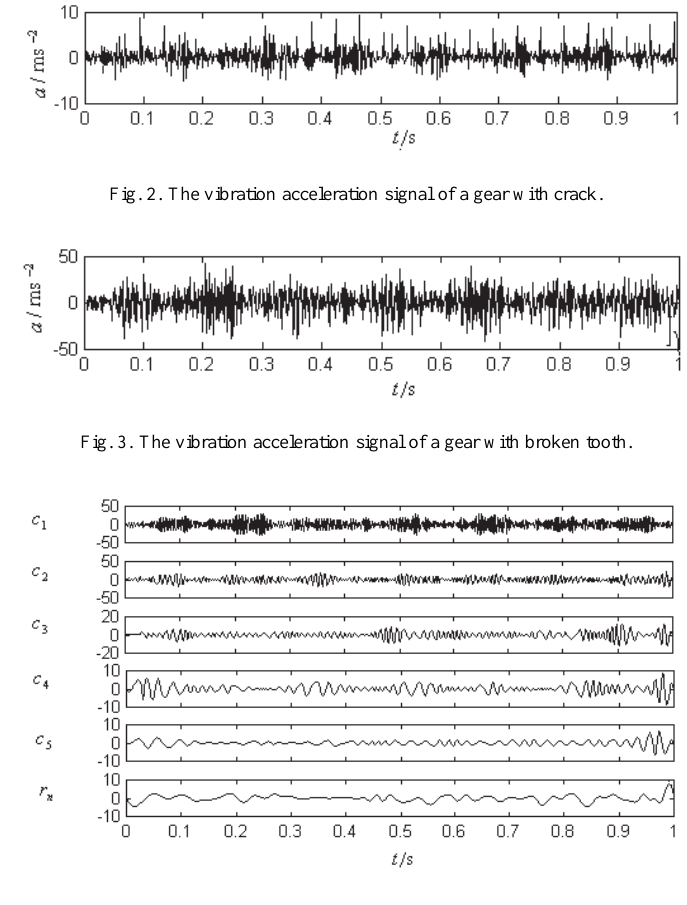
Fig. 4. The EMD decomposed results of vibration signal of the gear with broken tooth.